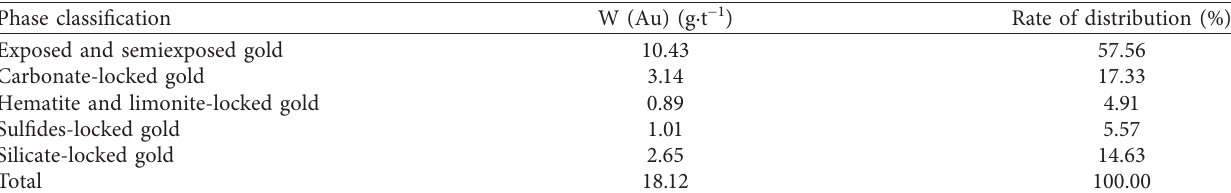
Figure 10: XRD analysis of volatile compounds from carbonaceous gold at 1,200 ° C. Table 7: Gold phase analysis of